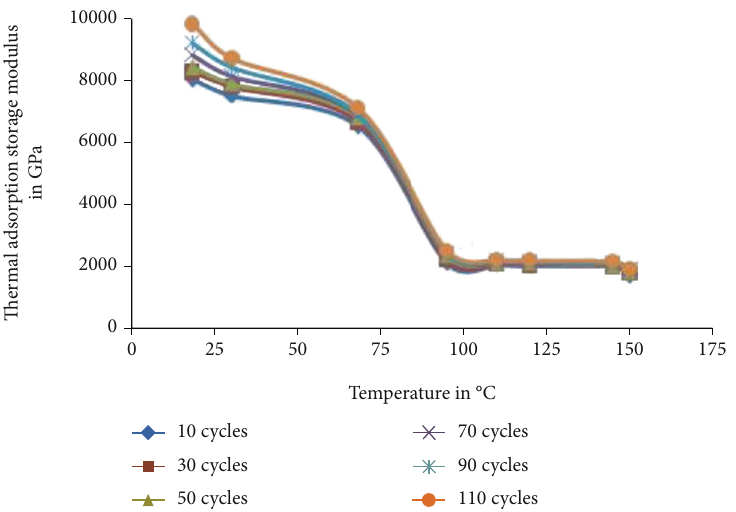
Figure 4: Thermal adsorption storage modulus of epoxy composites.